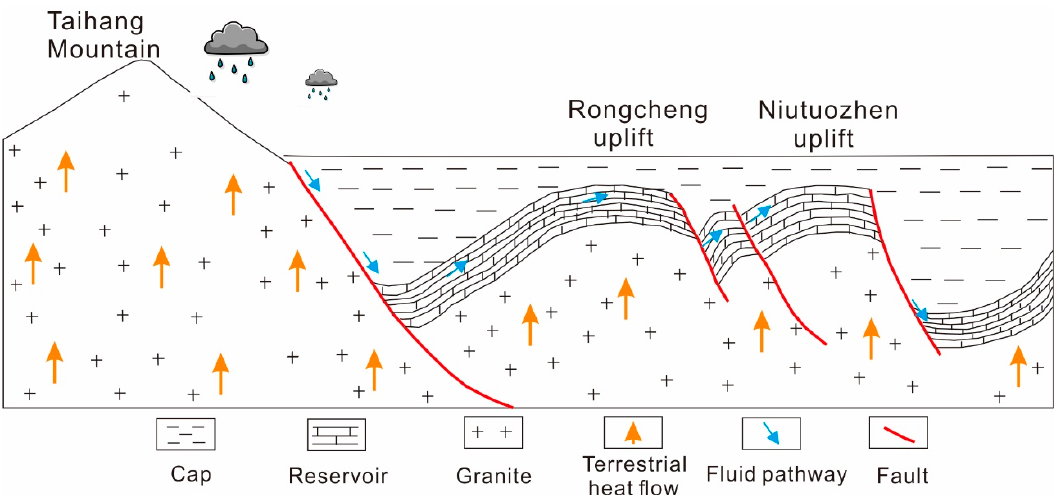
Figure 11. Conceptual model diagram of the genesis of geothermal resources in XNA (modified from [50]). from